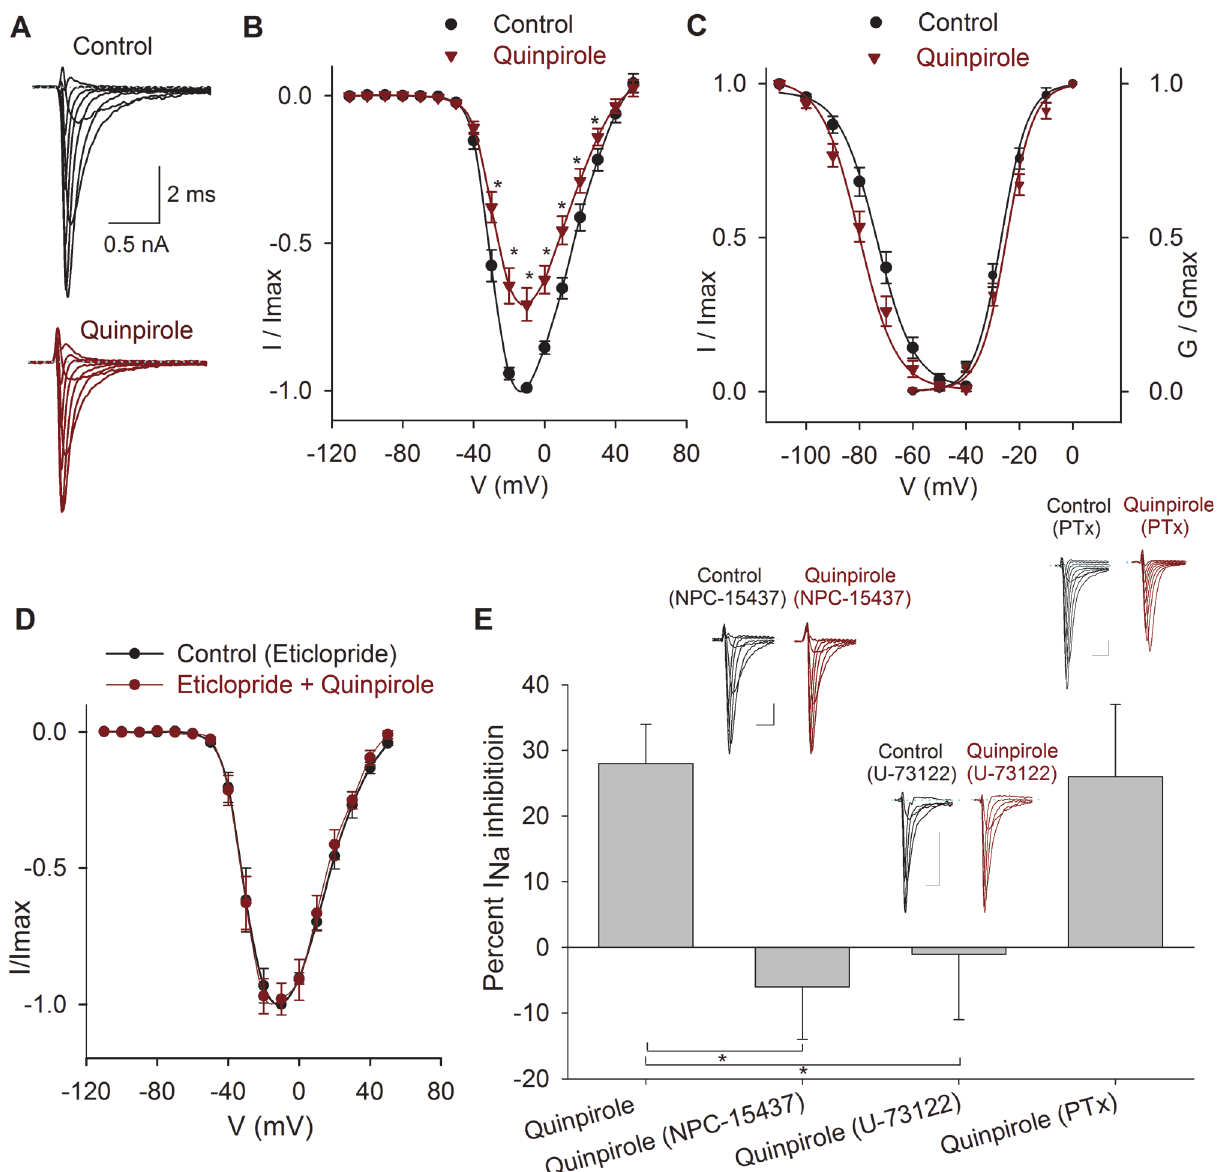
Fig 6. Effects of quinpirole on the I Na . A) Typical recordings of the I Na under control conditions and after 1 μ M quinpirole perfusion. B) Current- voltage relationship of the I Na in control conditions and after 1 μ M quinpirole. The maximum inhibition was 28 ± 6% at − 10 mV. C) Conductance activation and steady state inactivation curves of the I Na in control conditions and after 1 μ M quinpirole perfusion. Quinpirole caused a 5 mV hyperpolarizing shift in the V ½ of the inactivation curve. D) Current-voltage relationship of the I Na in control condition (with 1 μ M eticlopride) and after coapplication of 1 μ M quinpirole. E) Bar graph of the percent inhibition of the I Na by quinpirole in control, with NPC-15437 in the intracellular solution ( P = 0.004) and when the cells were preincubated with U-73122 ( P = 0.02) or PTx ( P = 0.82). Insets above bars show typical recordings of the I Na in control and after drug application. Calibration bars 0.5 nA, 1 ms for all